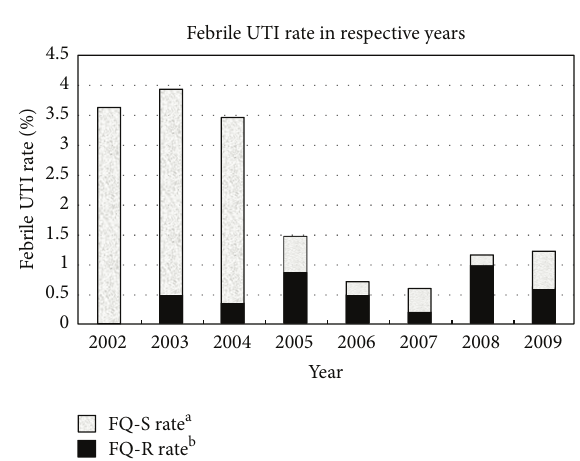
Figure 1: Febrile UTI rate per year of assessment. (a) FQ-S rate: fluoroquinolone-sensitive febrile UTI rate. (b) FQ-R rate: fluoroquinolone-resistant febrile UTI rate. The infection (febrile UTI) rates (%) were 3.6, 3.9, 3.5, 1.5, 0.7, 0.6, 1.2, and 1.2 in 2002, 2003, 2004, 2005, 2006, 2007, 2008, and 2009, respectively. The FQ-S rates (%) were 3.6, 3.4, 3.1, 0.6, 0.2, 0.4, 0.2, and 0.6 in 2002, 2003, 2004, 2005, 2006, 2007, 2008, and 2009, respectively. The FQ-R rates (%) were 0, 0.5, 0.3, 0.8, 0.5, 0.2, 1.0, and 0.6 in 2002, 2003, 2004, 2005, 2006, 2007, 2008, and 2009,